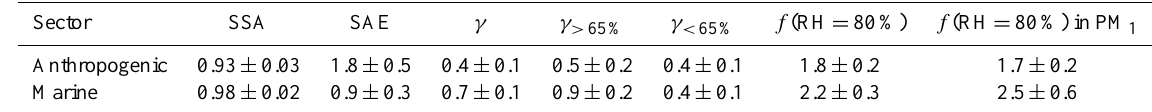
Figure 4. Example humidograms of the scattering enhancement factor, given as daily averages where the error bars represent the standard deviation for 9 March (a) and 31 May (b) . The black line denotes the γ fit for the entire RH range (RH>40%), the blue line denotes the γ fit for RH>65% and the red line the γ fit for the RH<65%. Table 1. Mean and standard deviation of single scattering albedo, scattering Ångström exponent, γ parameter, γ > 65% , γ < 65% and scattering enhancement factor at 80% RH for PM 10 fraction and scattering enhancement factor at 80% RH for PM 1 fraction for the two wind sectors. All the variables refer to 550 nm except the scattering Ångström exponent that has been calculated between 450 and 700nm.